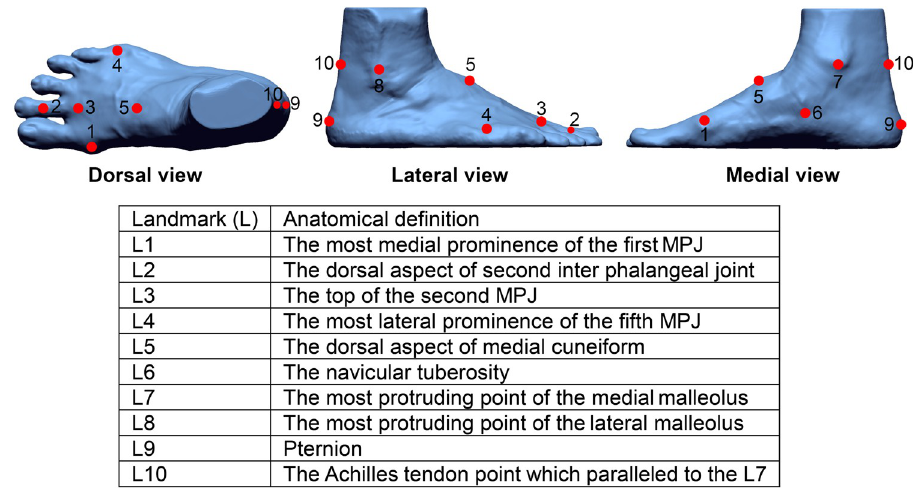
Fig 2. Location of 10 anatomical marker points on the right foot.